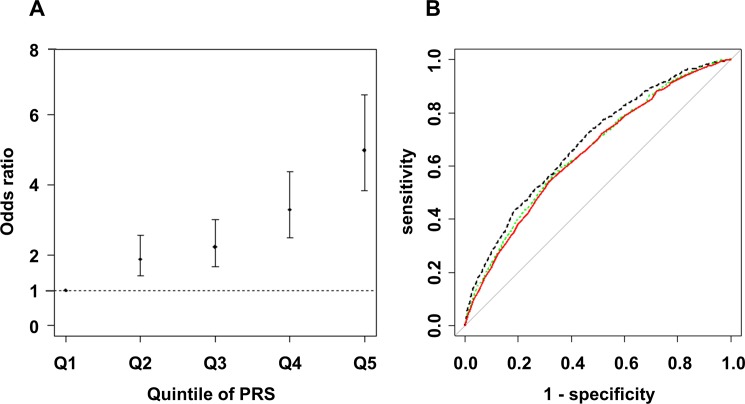
Risk estimation according to Polygenic Risk Scores for NAFLD patients compared with controls.The dot and bar denote the odds ratio (OR) and its 95% confidence interval in each quintile compared to the 1st quintile using rs2896019 in PNPLA3, rs1260326 in GCKR, and rs4808199 in GATAD2A (A), and the receiver operating characteristic (ROC) curve from the model (red line), and the ROC curves including previously reported SNPs (green dashed line) or candidate SNPs (p<1x10-4) identified in our GWA study (black dashed line) (B) are shown.